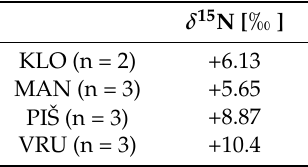
Table 3. Average δ 15 N values for H. trunculus (n = number of samples collected).